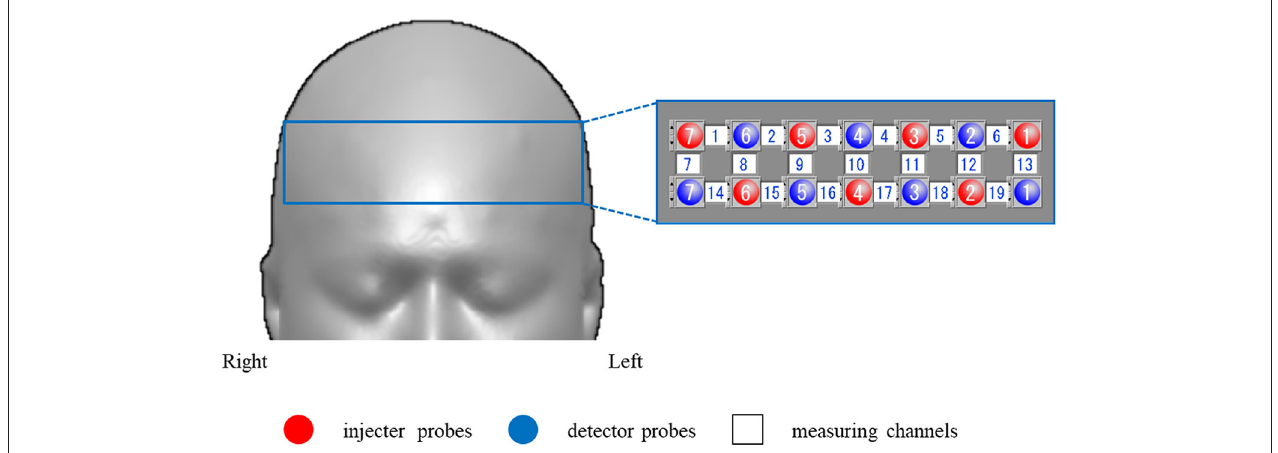
FIGURE 1 | Functional near-infrared spectroscopy (fNIRS) measurement points. We used a 19-channel system with 14 optodes, seven injector probes, and seven detector probes solid white numbers denote the channels of